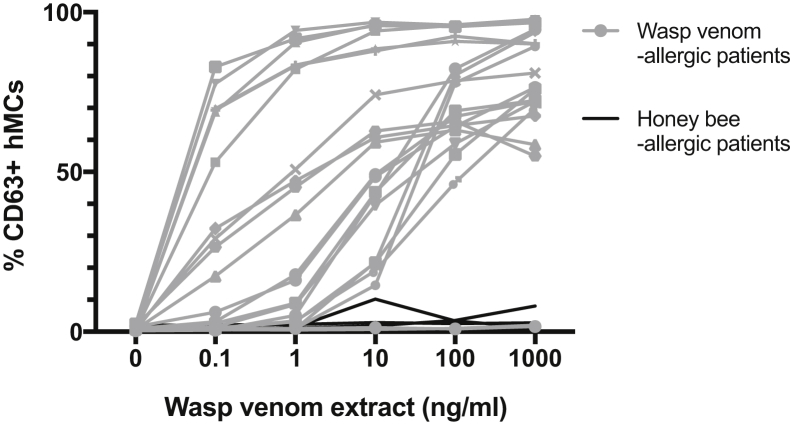
hMC degranulation in patients with a clinical history of systemic reaction to wasp (n = 21) or honeybee (n = 6) venom. hMCs were sensitized overnight with patients' sera, washed, and then incubated with varying concentrations of wasp venom extract (as indicated) for 1 hour. hMC degranulation was measured based on CD63 surface expression by using flow cytometry.